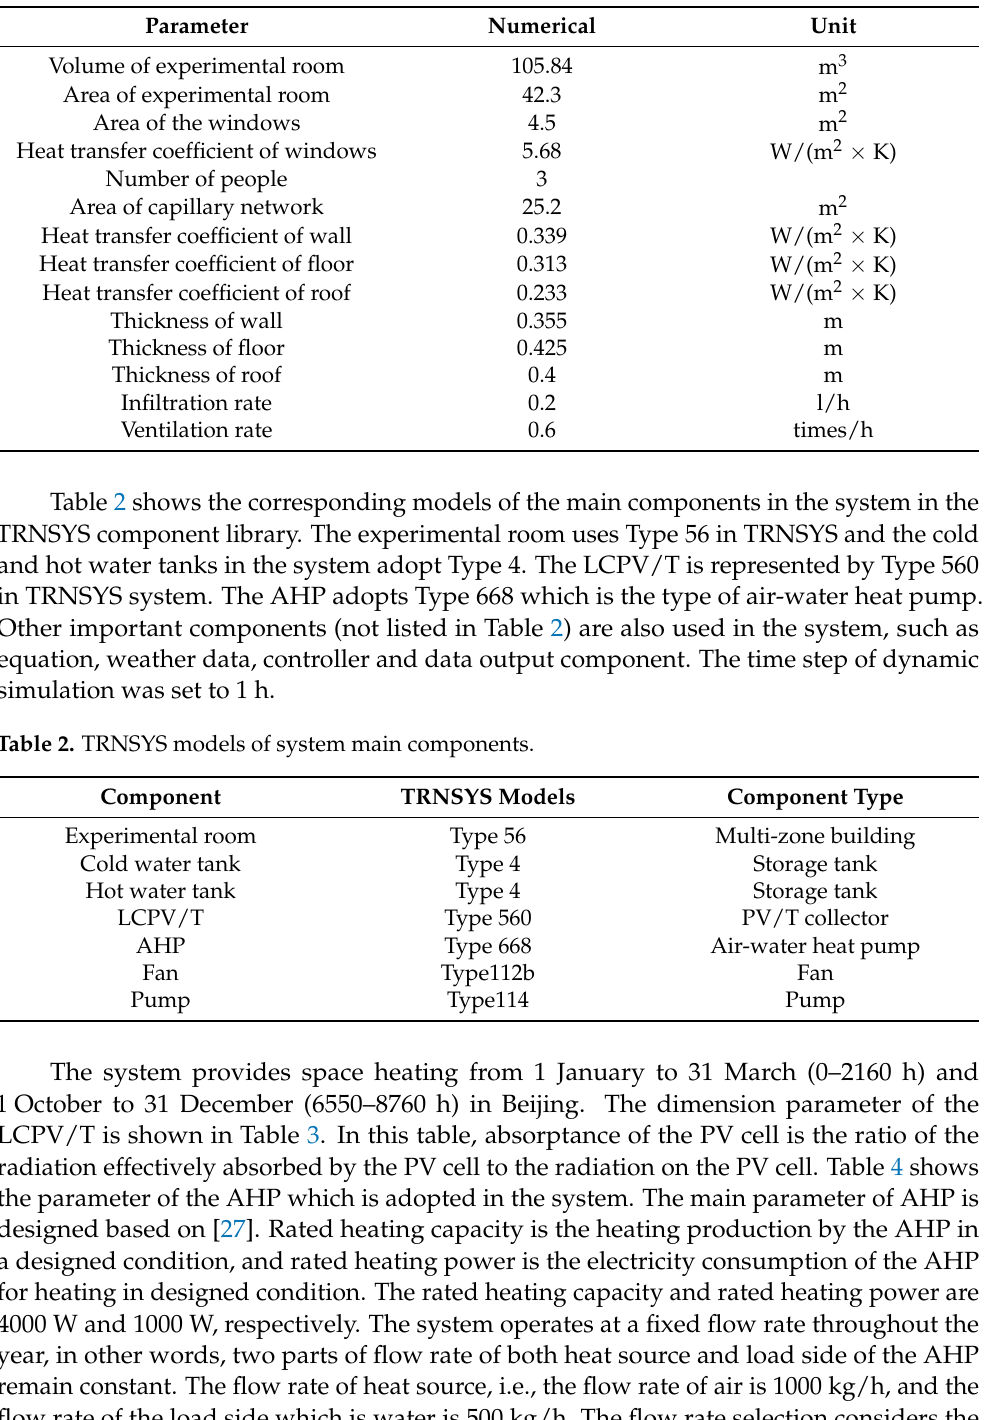
Table 1. The parameters of rooms.